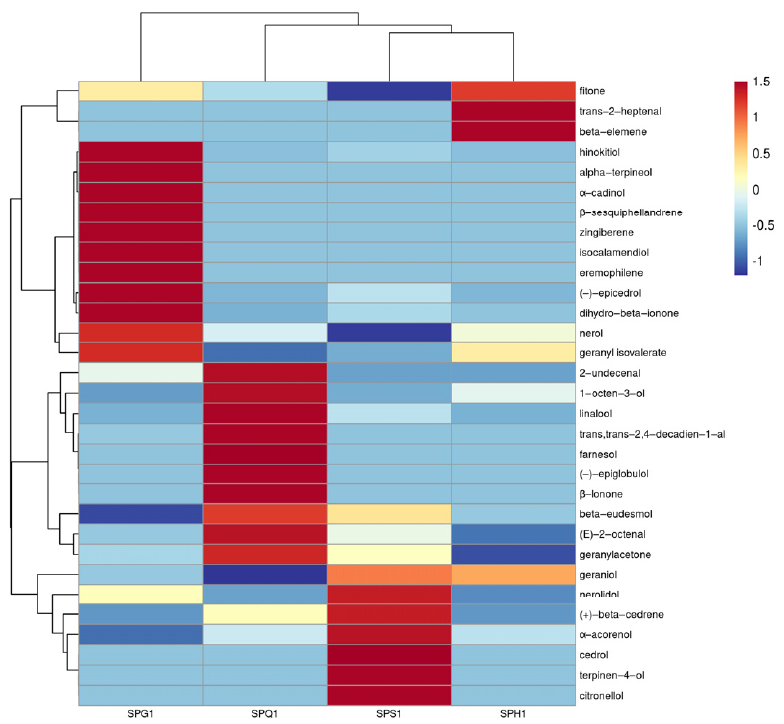
Figure 3. Heat map of the content of terpene products from liquid-state fermentation of different strains. The concentrations of terpene compounds produced by the four strains were SPQ1 (423.67 µ g/kg) > SPS1 (258.02 µ g/kg) > SPH1 (160.14 µ g/kg) > SPG1 (148.11 µ g/kg), and the quantities of terpene compounds produced were SPG1 (21 species) > SPS1 (18 species) > SPQ1 (16 species) > SPH1 (14 species). SPS1, SPQ1 and SPH1 had the best effect on terpene